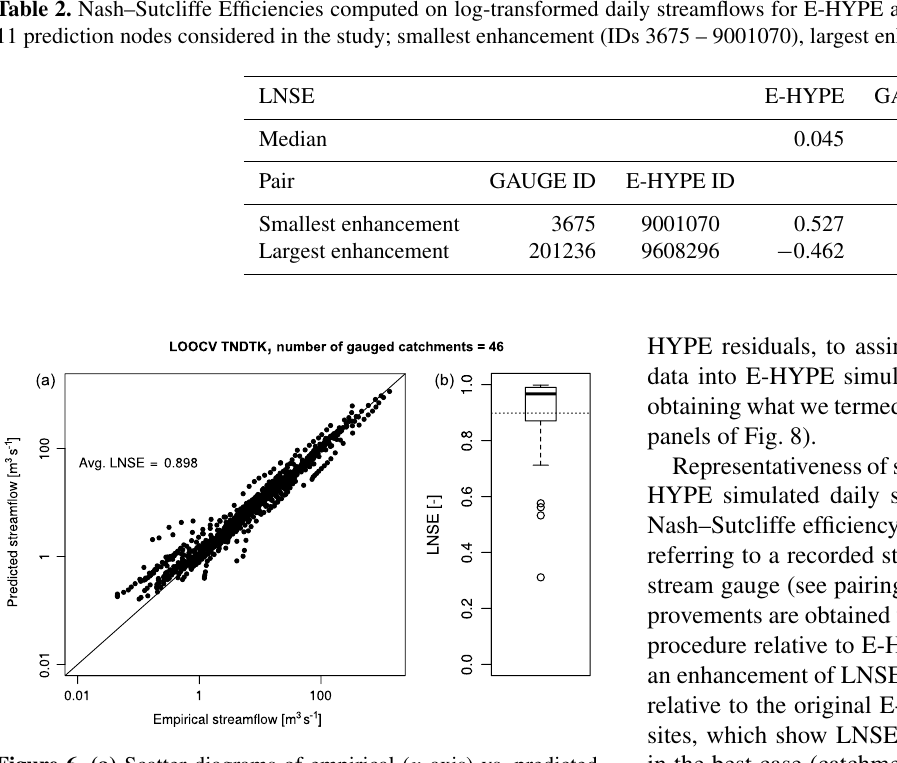
Figure 6. (a) Scatter diagrams of empirical ( x axis) vs. predicted ( y axis) streamflows. (b) Box-plot representation of on-site LNSE values, summarizing the first, second (median) and third quartiles along with whiskers extending to the most extreme non-outlying data point (outliers are highlighted as circles and lay at more than 1.5 times the interquartile-range from the nearest quartile); the aver- age on-site LNSE value is reported in (a) and illustrated as a dashed line in (b)